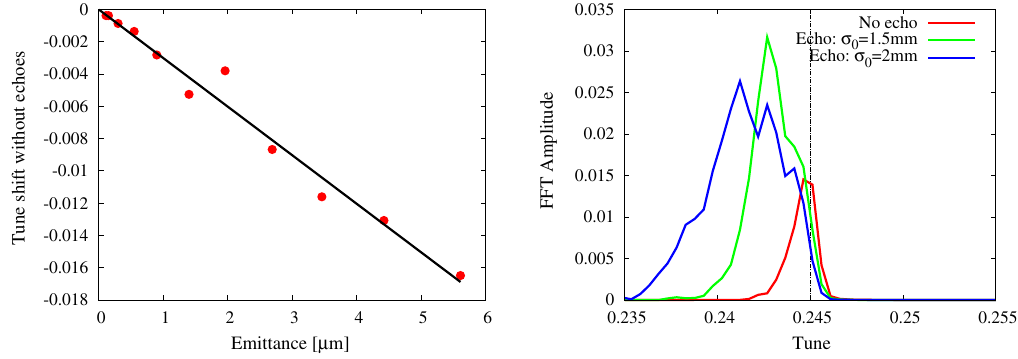
FIG. 10. Left: tune shifts (without echoes) vs the emittance. The emittance was changed by varying dipole kicks. Also shown is the straight line fit which yields the tune slope parameter ν 0 . Right: spectra without echo and with echoes. The spectrum without an echo was obtained with q ¼ 0 while the echo spectra were obtained with the same dipole kick (1 mm), the same value of q ¼ 0 . 01 , and two initial emittances corresponding to σ 0 ¼ 1 . 5 mm and σ 0 ¼ 2 mm. The vertical dashed line shows the bare lattice